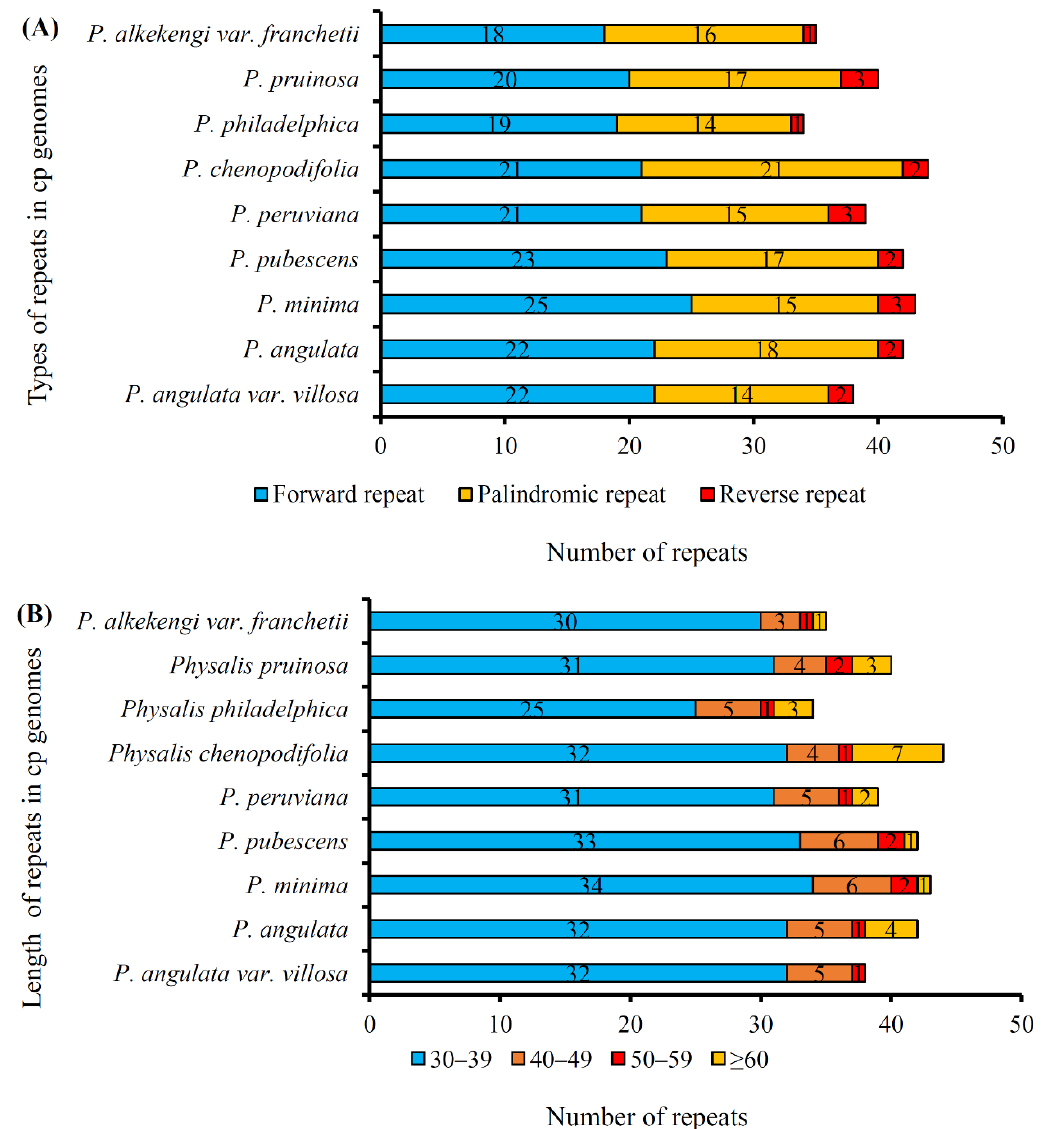
Figure 4. Repeated sequences in the plastomes of nine Physalis species. ( A ), Three repeat types (forward, reverse and palindromic repeats) in the nine Physalis plastomes; ( B ), Numbers of repeat (forward, reverse and palindromic) sequences by length.